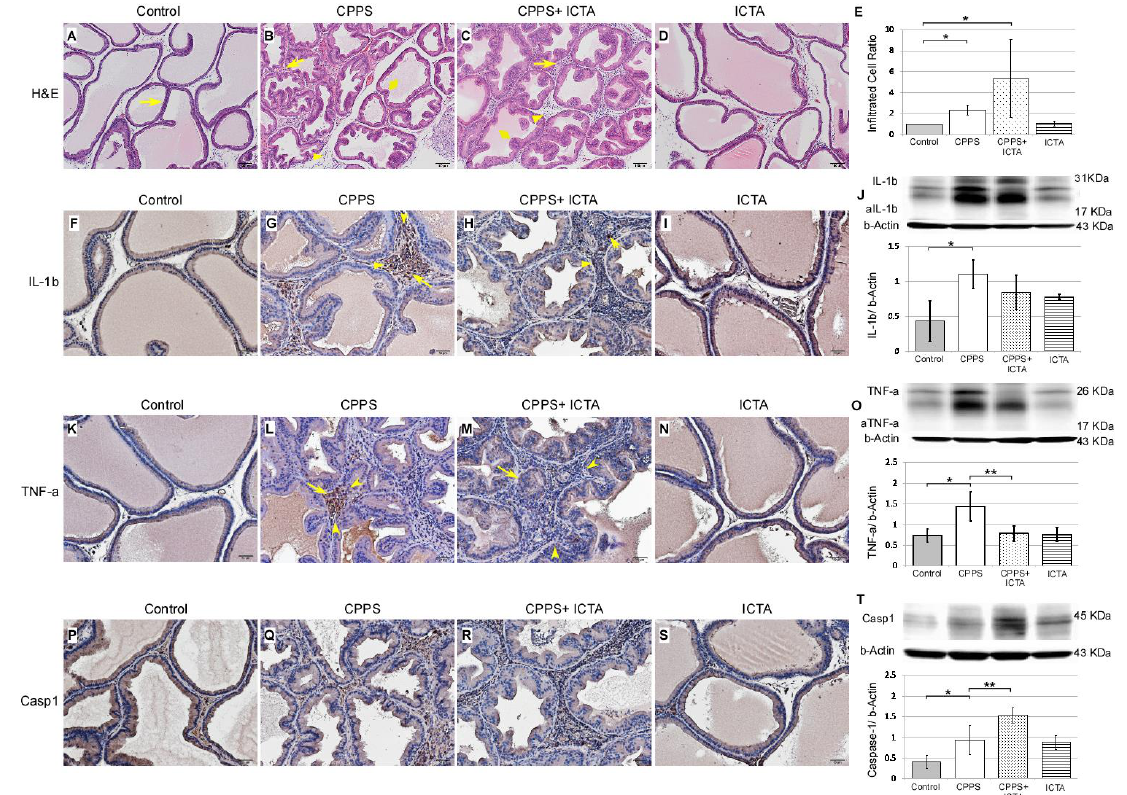
Figure 3. Inflammatory cytokine-targeting aptamers (ICTA) affected carrageenan-induced